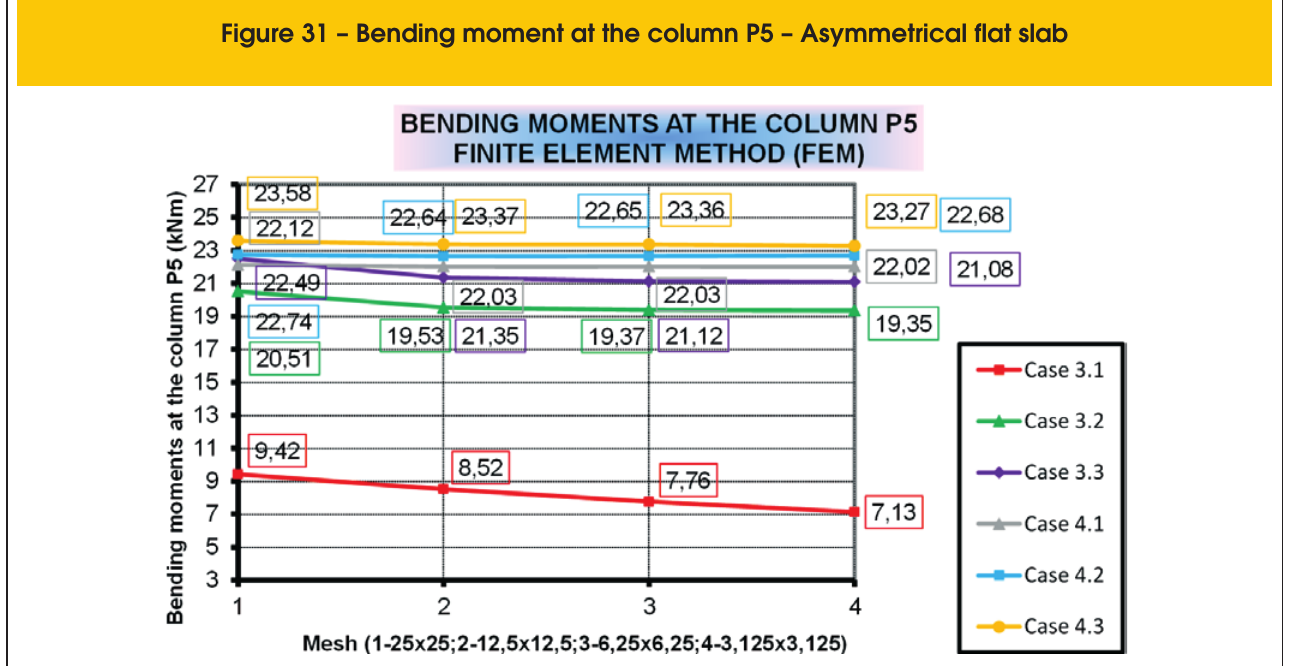
Figure 31 – Bending moment at the column P5 – Asymmetrical flat slab